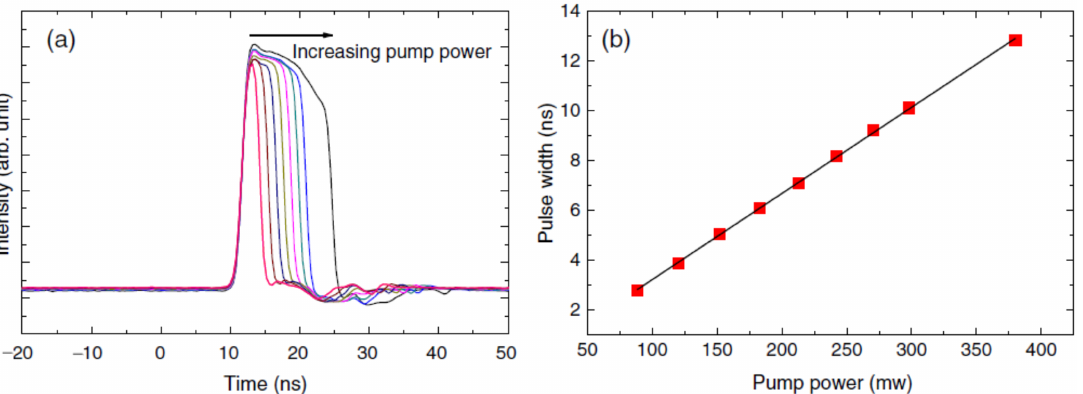
Figure 16. ( a ) Measured single pulses with an increasing pump power. ( b ) Measured output pulse width as a function of the pump power. Reprinted with permission from [75].